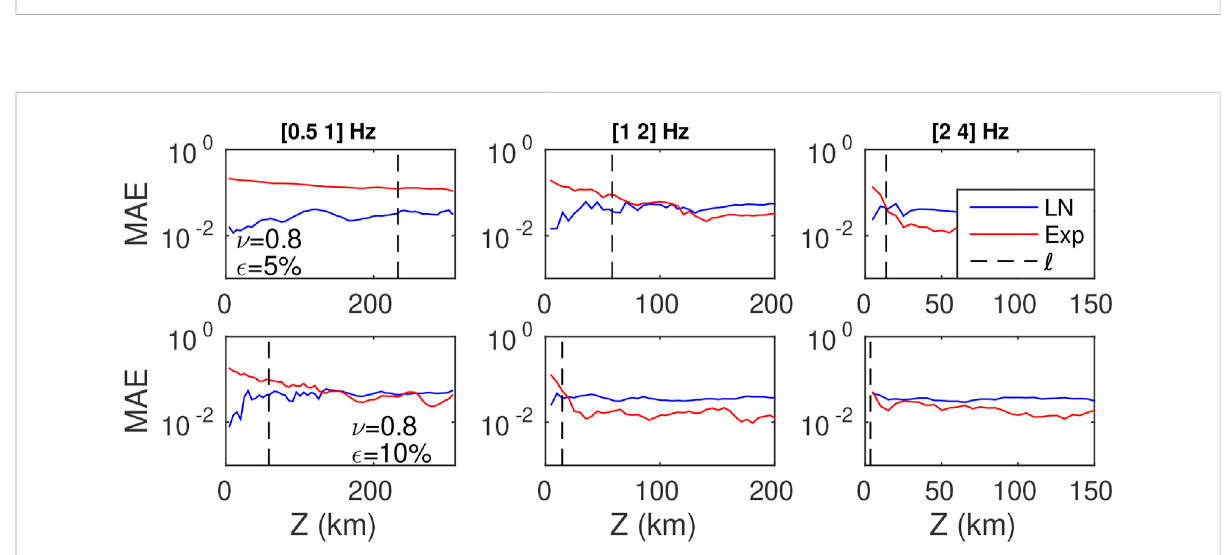
FIGURE 11 Distance dependence of intensity distributions at the ballistic peak for cases ε = 5%. Blue and red lines are the log-normal and exponential distributions, respectively. The dotted black line corresponds to the value of scattering mean free path for each speci fi c central frequency.